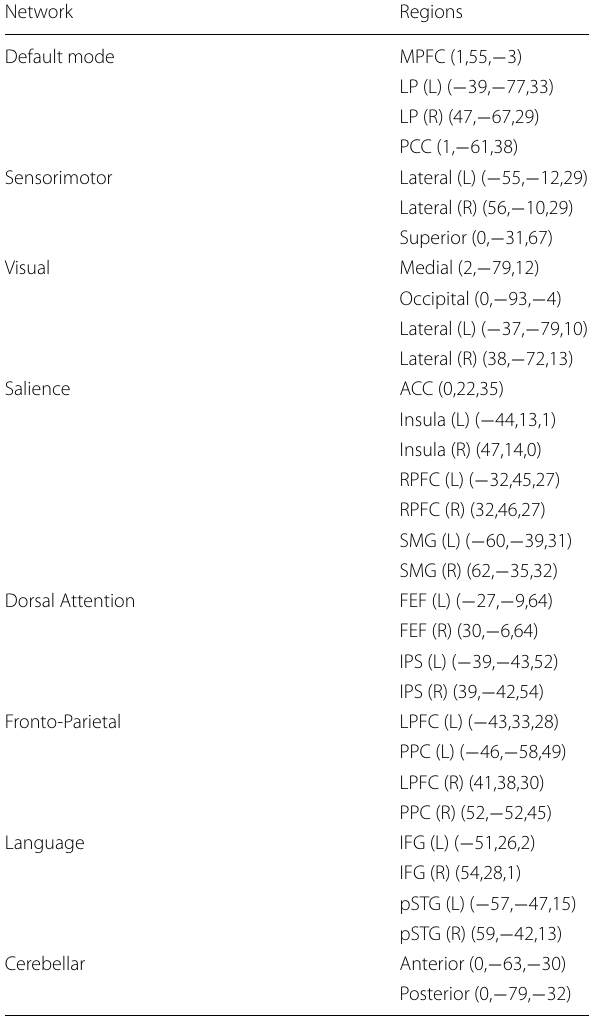
Table 1 Targeted networks with the regions that comprise them. Also shown the coordinates of these